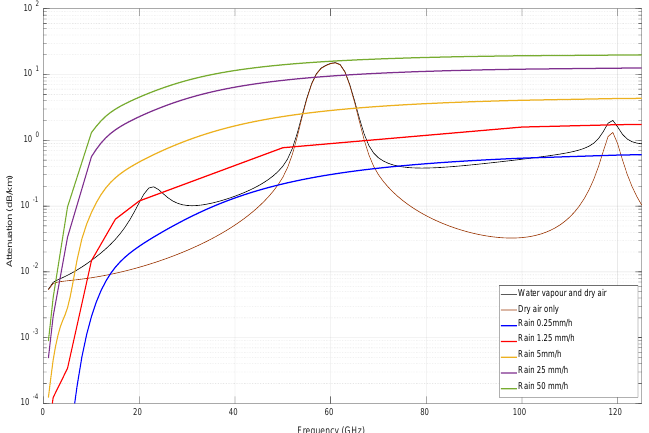
Figure 1. Frequency-dependent attenuation of electromagnetic radiation in standard atmosphere (barometric pressure 1013 mbar, temperature 15 °C, water vapor density of 7.5 g/m3) and rain attenuation in dB/km at various rainfall rates.